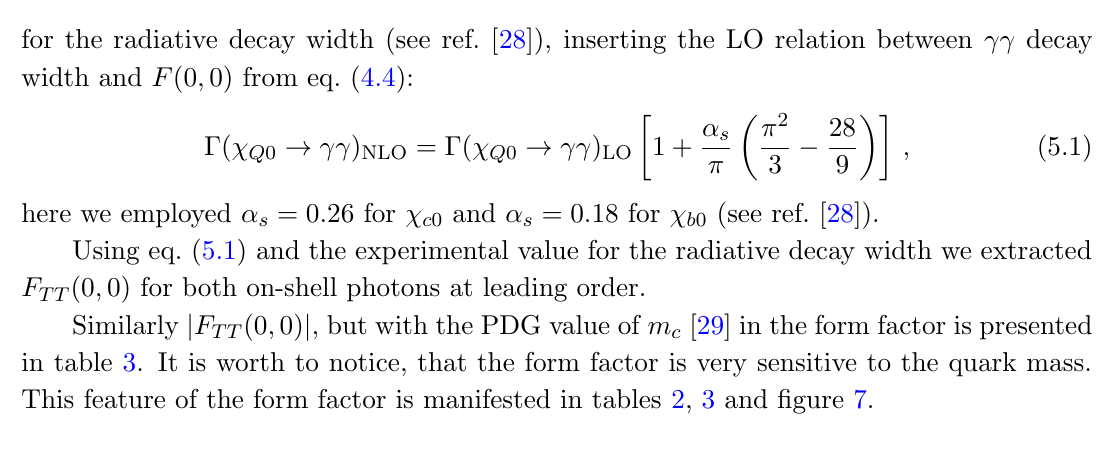
Table 1 . Values for meson mass, (cid:0) tot , and the branching ratio Br( (cid:31) Q 0 ! (cid:13)(cid:13) ) = (cid:0)( (cid:31) Q 0 ! (cid:13)(cid:13) ) = (cid:0) tot according to the Particle Data Group